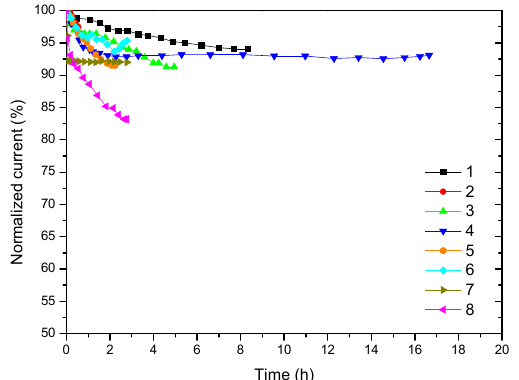
Figure 6. Comparison of ORR activity in terms of half-wave potential. (Ref. from left to right bars: [85], [86], [84], [87], [88], [89], [90], [91], [92]). Catalysts 2016 , 6 , 159